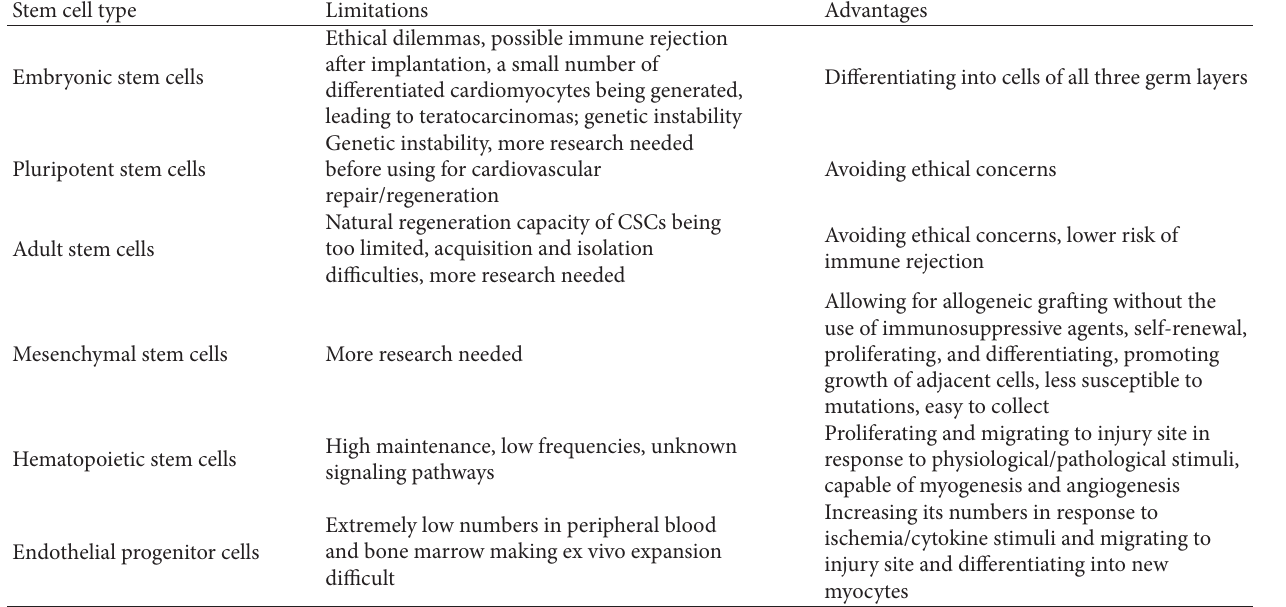
Table 1: Comparison of advantages and limitations of different types of stem